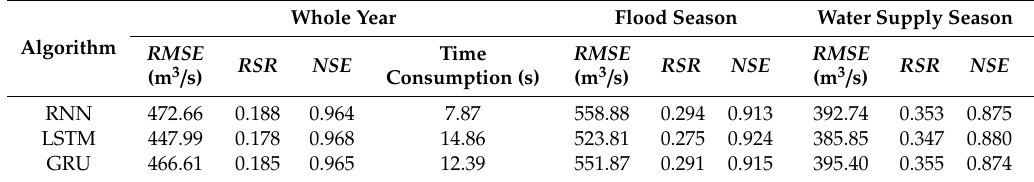
Table 2. The performances of RNN, LSTM, and